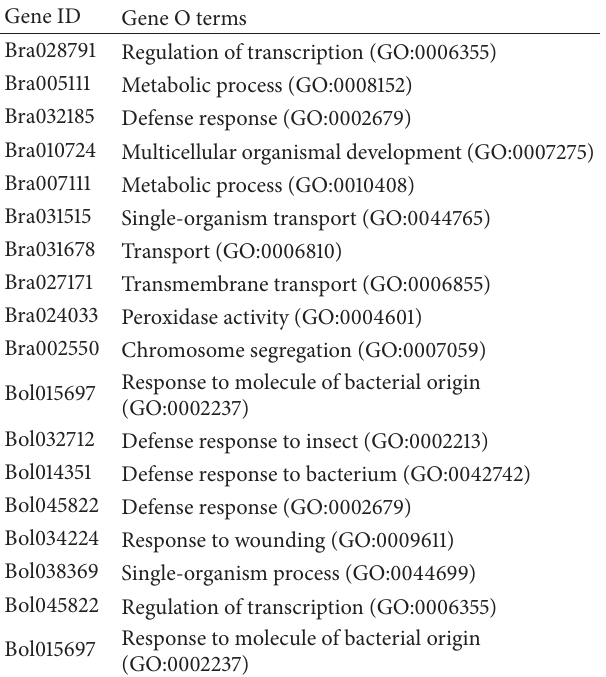
Table 2: Significant gene ontology terms of high-parent dominance (HPD) in the biological process category from A and C